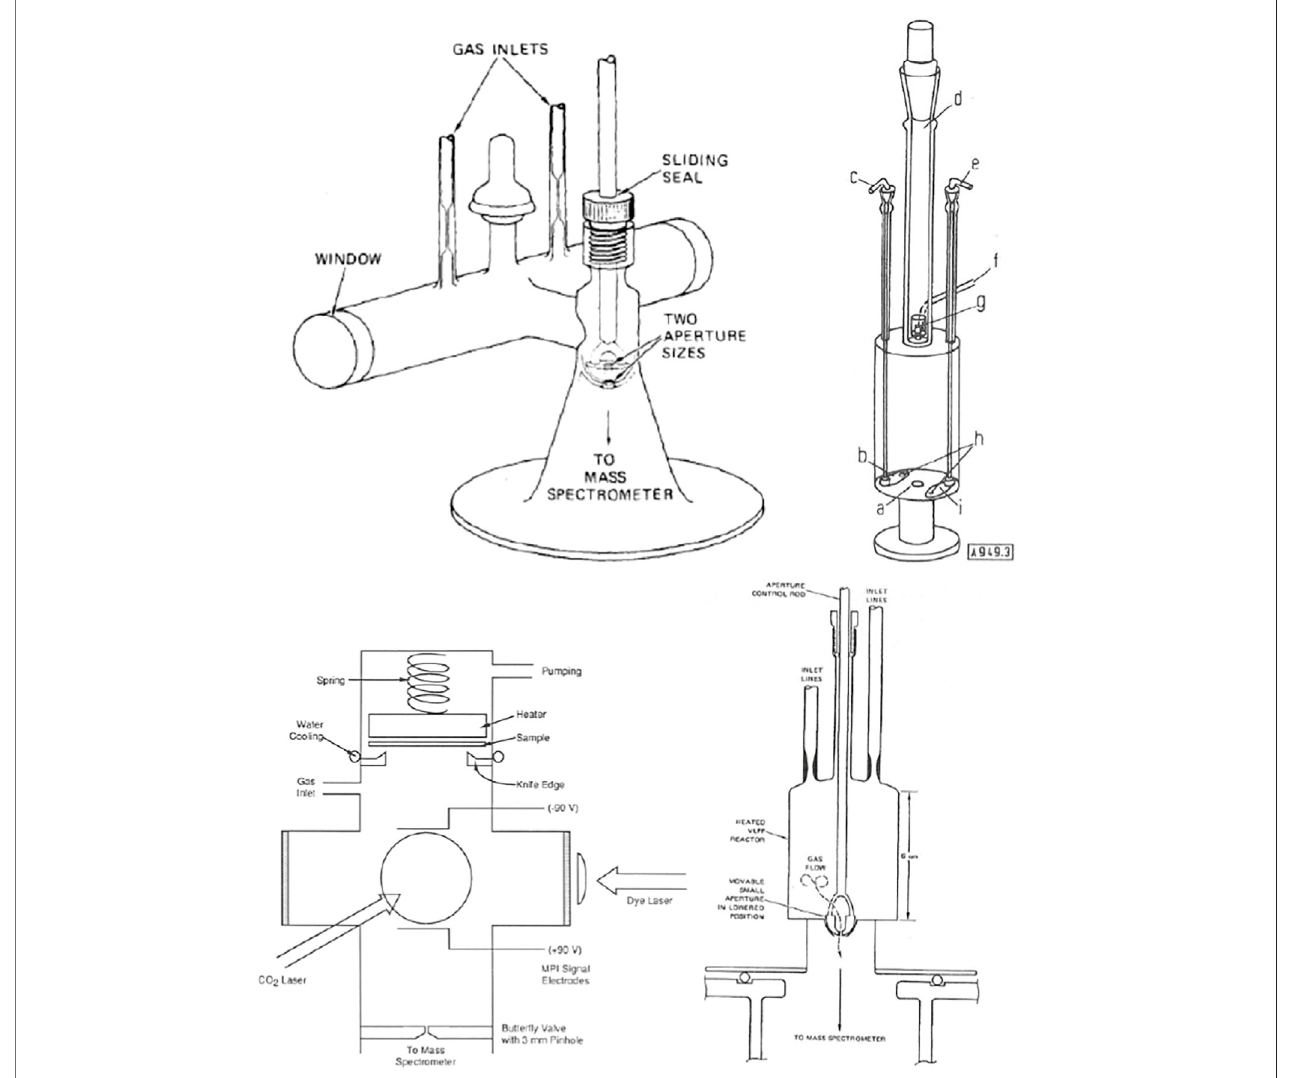
FIGURE4| FourdifferentembodimentsofKFR ’ s: UpperLeft :Perspectivedrawingofthetwo-apertureVLP ϕ (VeryLow-PressurePhotolysis)reactor fi ttedwithKCl windowsused inIRmultiphoton-generated freeradicals work.TheID oftheirradiation tube is2.0 cm,the opticalpathlength is20.5 cm,and thetotalvolume is105 cm 3 (Rossi et al., 1979a); Upper Right : Triple aperture quartz reactor system; a hole (1 cm Ø), b aperture plate (3.3 cm Ø); c 3.3 cm aperture plate manipulator; d removable section with ground joint; e 1 mm aperture plate manipulator; f gas inlet tube; g device for heating of solids and pyrolysis of emerging gases; h aperture plates may be independently moved tocover 1 cm exit ori fi ce; iaperture plate (1 mm Ø) (Golden et al., 1973); Lower Left : All-stainlesssteel KFR equipped for studying the interface of Si wafers located on top and interacting with atoms and free radicals, the latter generated by IR multiphoton decomposition using a TEA CO 2 -laser and monitored by Resonance-Enhanced Multiphoton Ionization (REMPI) using a tunable dye laser. The in situ detection of the transient free radicals and atoms is enabled by circular electrodesbiasedbyplusorminus90Vfromabatterypack(Robertson etal.,1988); LowerRight :QuartzVLPPReactorforthestudyofhightemperature homogeneous gas reactions of 133.5 cm 3 volume, ω = 4,982 (T/M) 1/2 and nominal 1 and 3 mm exit ori fi ce